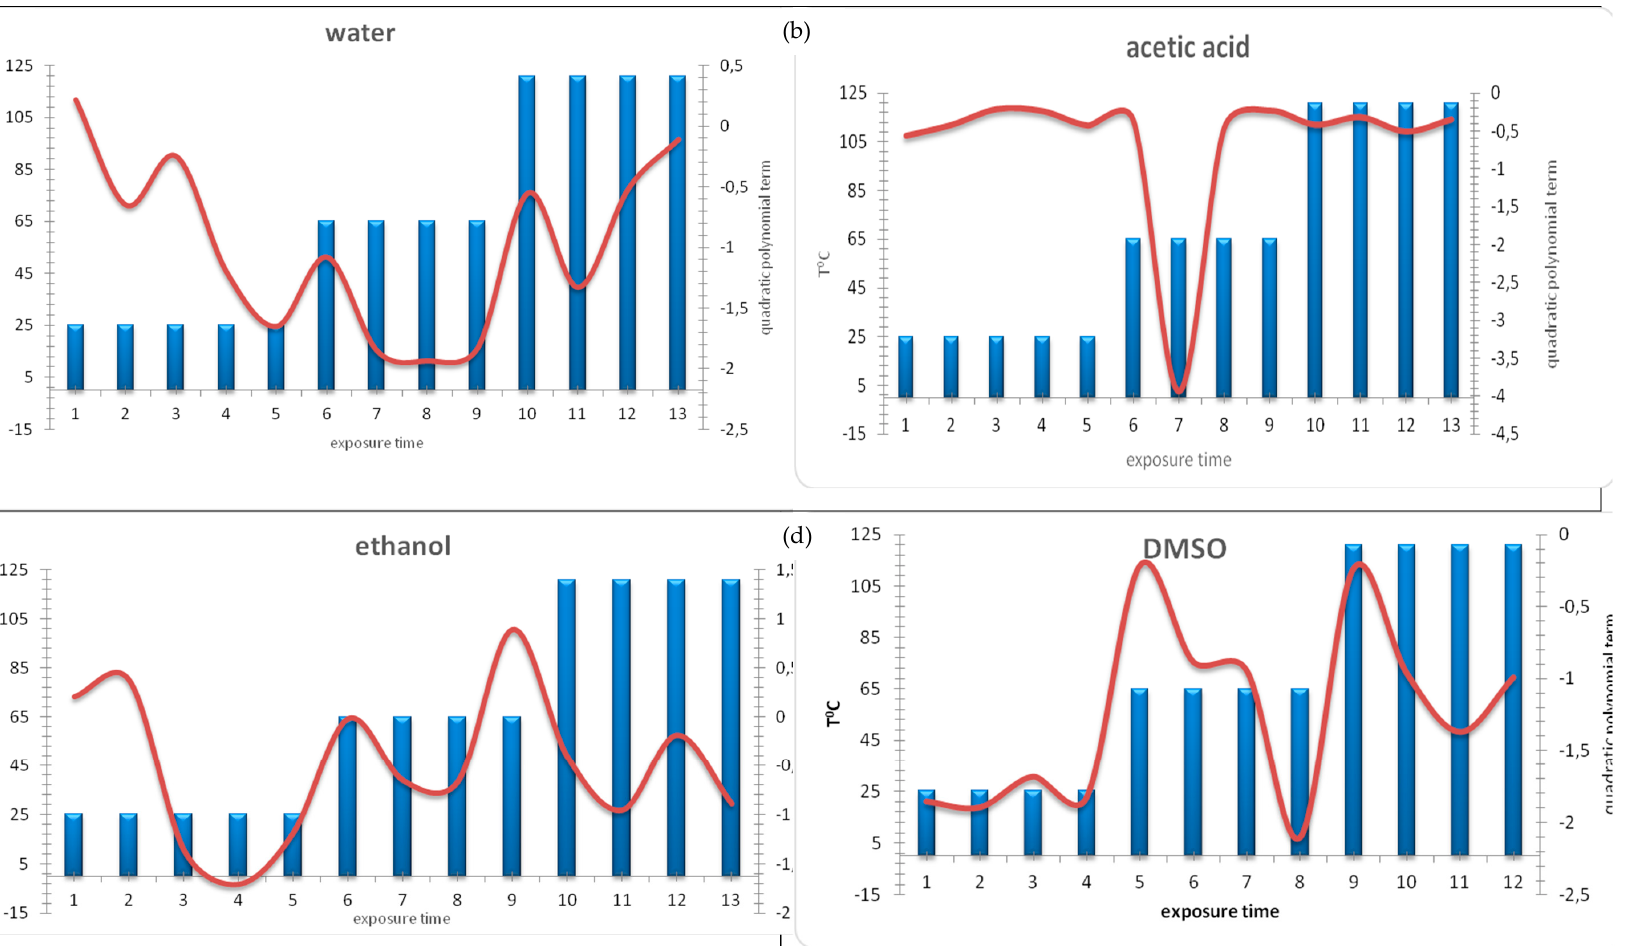
Figure 2. Change of impact of exposure time on ecotoxicity signal in ( a ) water samples for three different temperatures, ( b ) acetic acid medium for two different temperatures, ( c ) in ethanol medium for three different temperatures, ( d ) DMSO medium for three different temperatures.